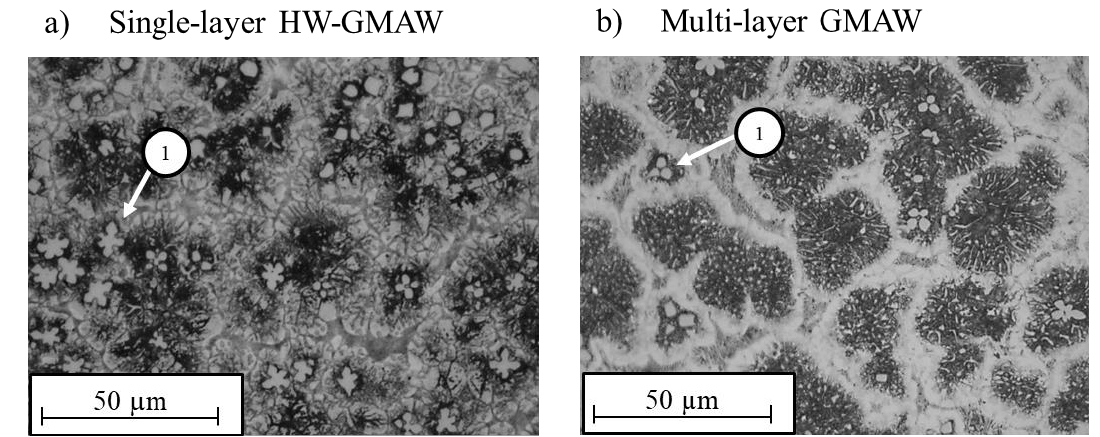
Figure 10. Microstructure and characteristic of primary VCs (1) of ( a ) a single-layer HW-GMAW, v GMAW = 5 m/min, v HW = 5 m/min, v S = 300 mm/min; and ( b ) a three-layer GMAW overlay, v GMAW = 5 m/min, U GMAW = 29 V, v S = 300 mm/min.